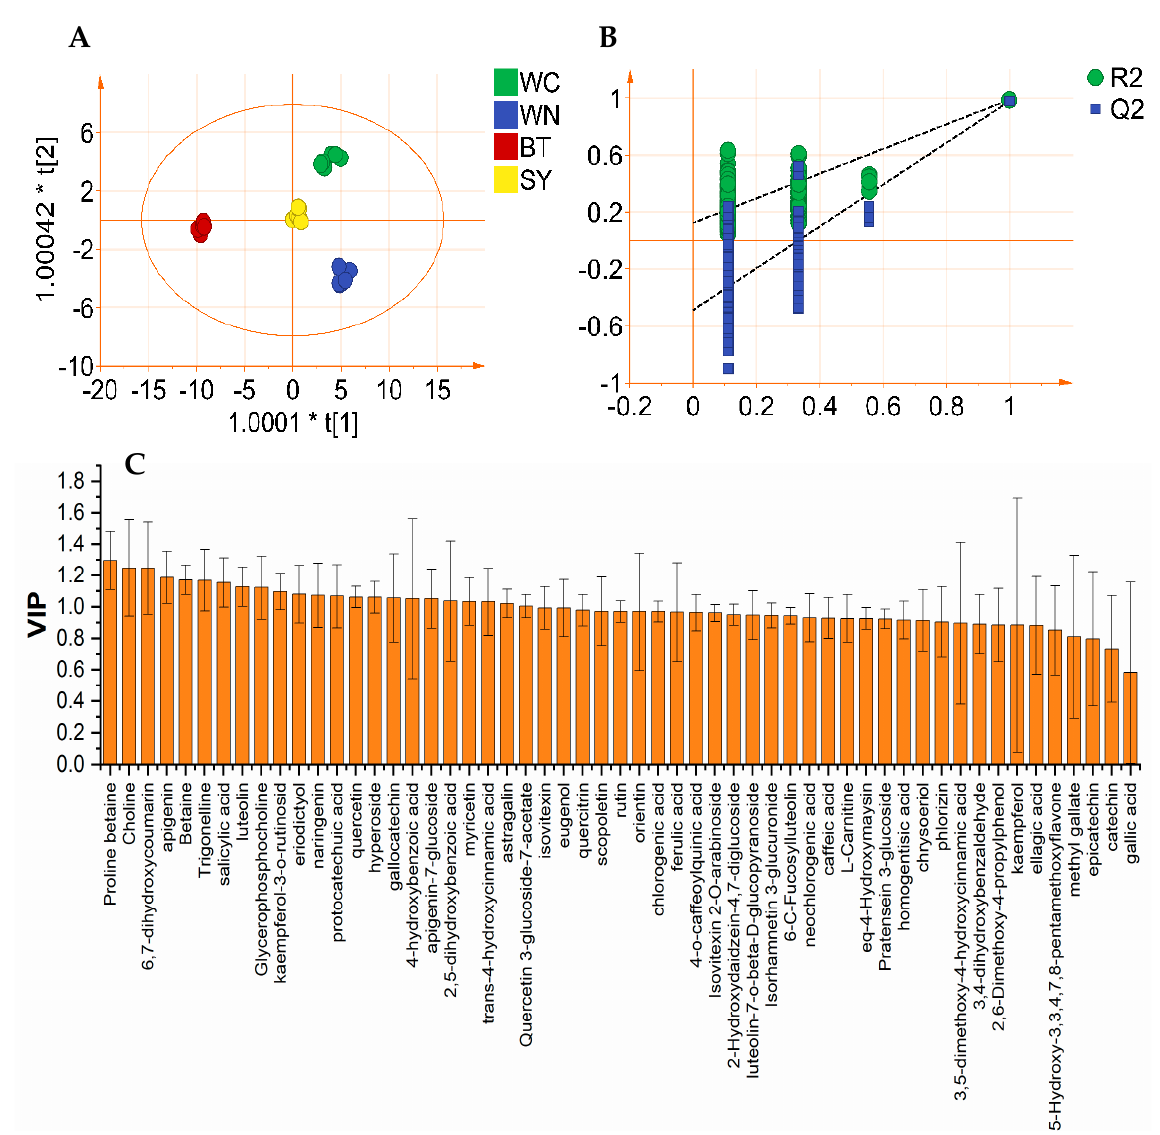
Figure 6. OPLS-DA results of polyphenol and alkaloid content of partridge tea from four origins (SY, WN, WC, and BT): ( A ) 2D scores plot of OPLS-DA; ( B ) result map of 200 cross-validation of OPLS-DA model; ( C ) VIP map of contribution of each variable to sample classification.